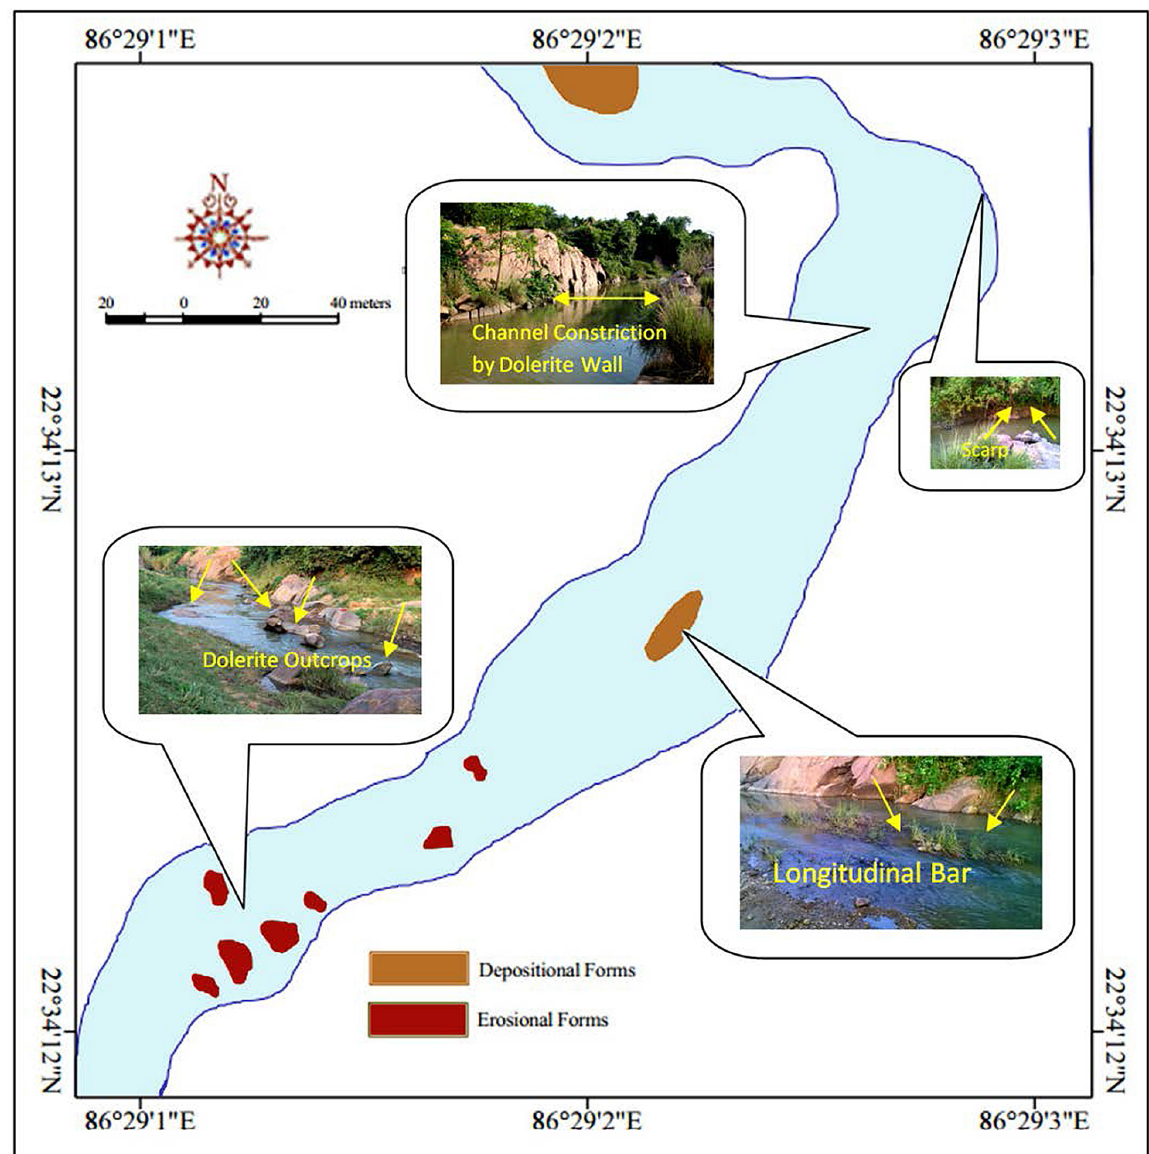
Fig. 11. In-channel forms of Middle